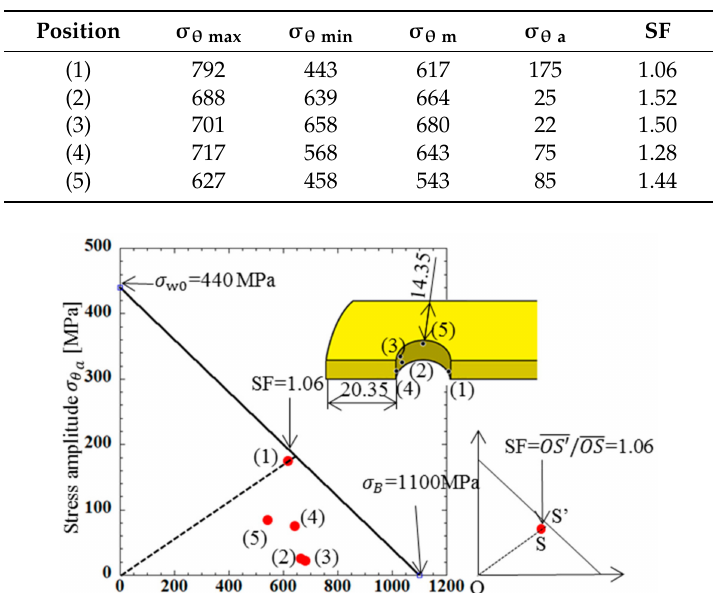
Figure 10. Stress distribution σ θ for the outer plate [MPa]: ( a ) press-fitting state; ( b ) tensile state; ( c ) engaging state. Table 6. Maximum stress σ θ max and minimum stress σ θ min , mean stress σ θ m and stress amplitude σ θ a for outer plate [MPa].